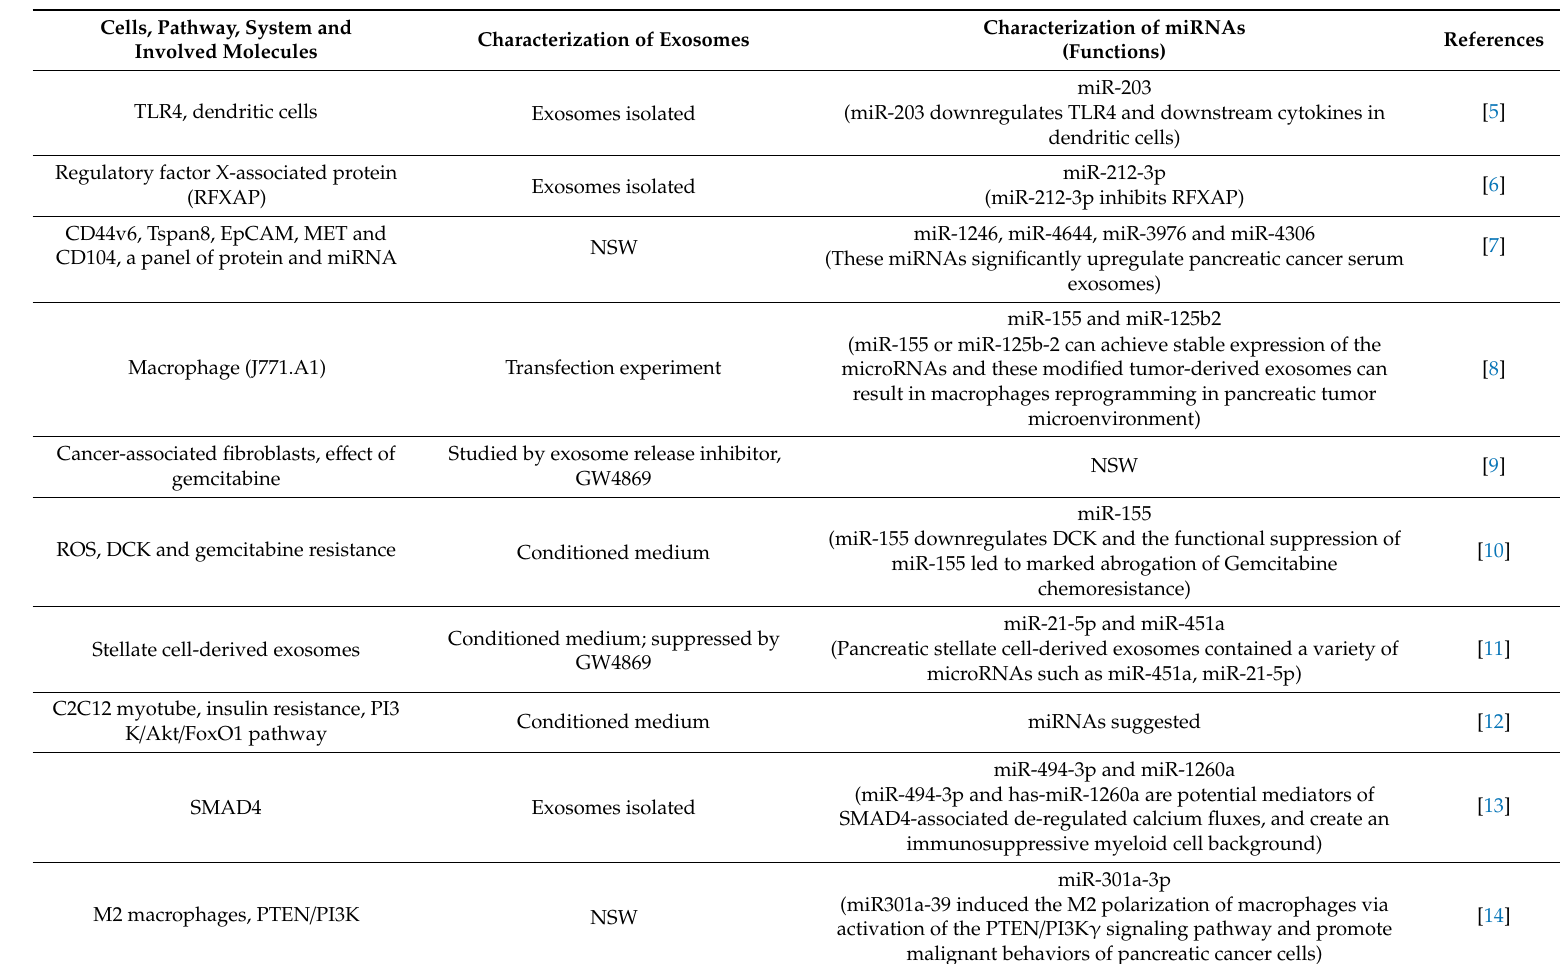
Table 1. Nonclinical study of exosomes and miRNAs in pancreatic